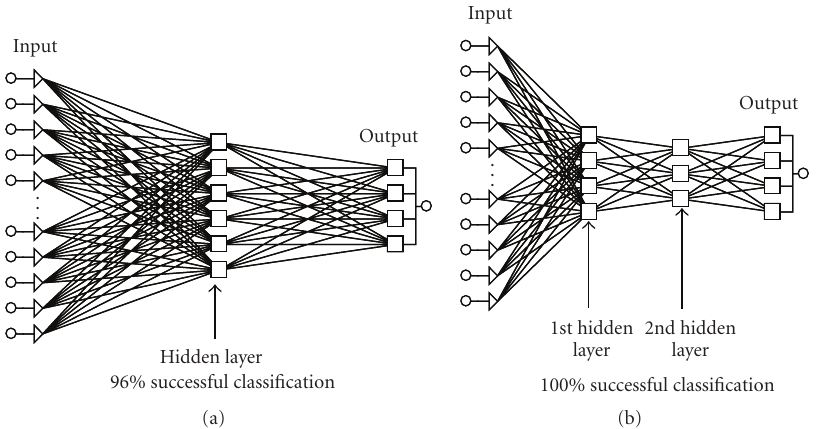
Figure 5: (a) Structure of the optimal 3-layer ANN architecture (72, 6, 4). (b) Structure of the optimal 4-layer ANN architecture (72, 3,